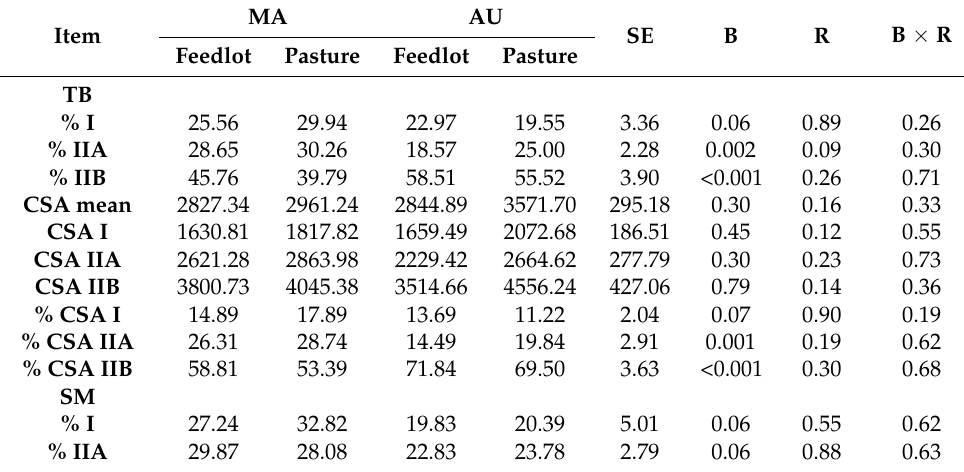
Table 2. Effect of the breed (B), rearing system (R), and their interaction (B × R) on histochemical characteristics and gene expression in Triceps brachii (TB) and Semimembranosus (SM) muscles of AU and MA steers 1